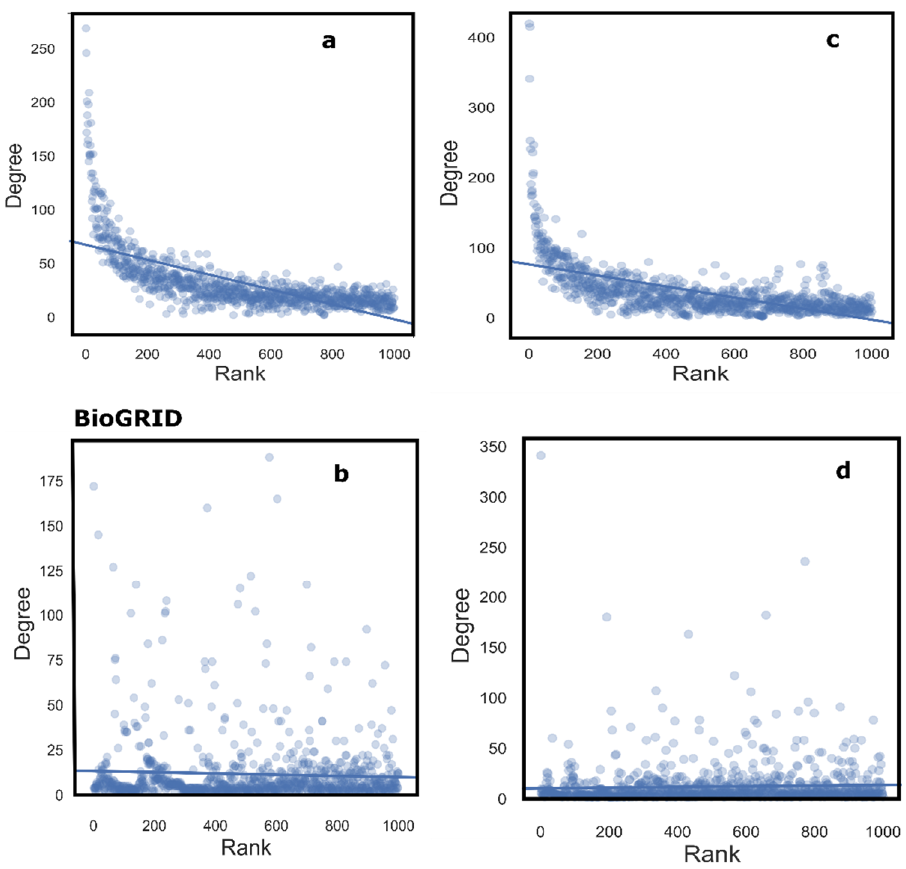
Figure 2. Correction of degree bias; Rank of top 1000 genes in HPRD (top) and BioGRID (bottom) based on ( a , b ): Betweenness centrality with no background correction and ( c , d ): p values. In ( a ) and ( b ), the highest-ranking nodes in the MD network are some of the highest degree nodes in the PPI network. In the background-corrected networks ( c , d ), we find a more uniform distribution of the ranking vis-à-vis the corresponding degree of the node. Some of the highly ranked nodes have degrees lower than 50. However, highly connected genes are also seen to be present in the top-ranking genes, which indicates that their contribution to the MD network is significant. Thus, the method allows for highlighting both low-degree and high-degree nodes in the top-ranking genes, which was not the case when only uncorrected betweenness centrality was used.